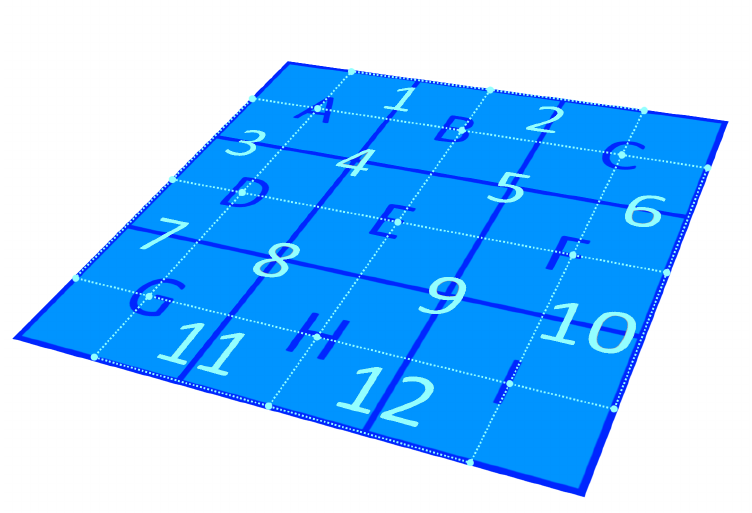
Figure 3. Schematic representation of the automated boundary error correction strategy. Squares labeled with letters and outlined with continuous lines correspond to LiDAR zones. Rectangles labeled with numbers and outlined with dots delimit overlapping sections between adjacent zones that will be used as correction patches to detect and remove classification errors located on the boundaries of the